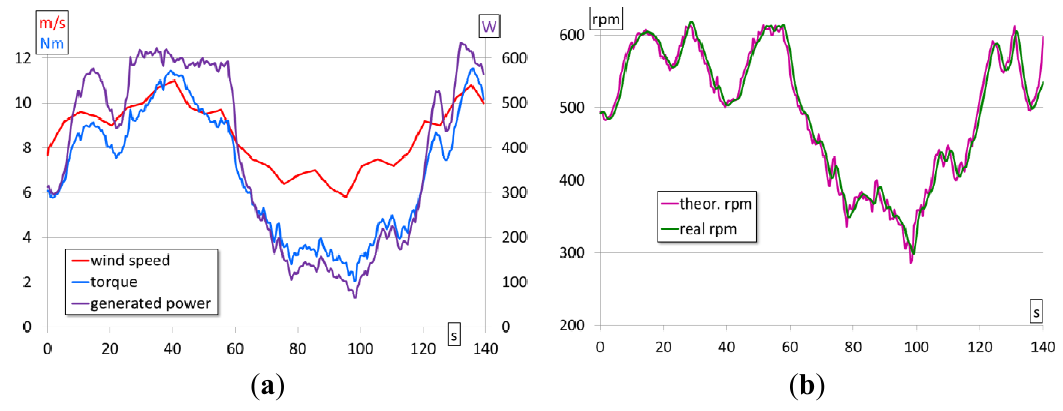
Figure 6. ( a ) Wind speed sample, turbine torque and generated power; ( b ) Theoretical and real rotational speed of the